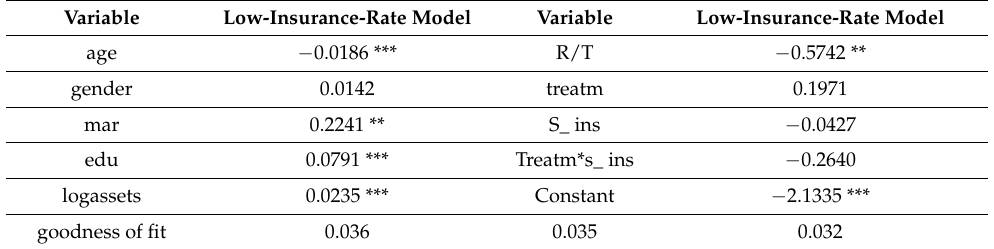
Table 3. Regression results of social medical insurance and commercial medical insurance